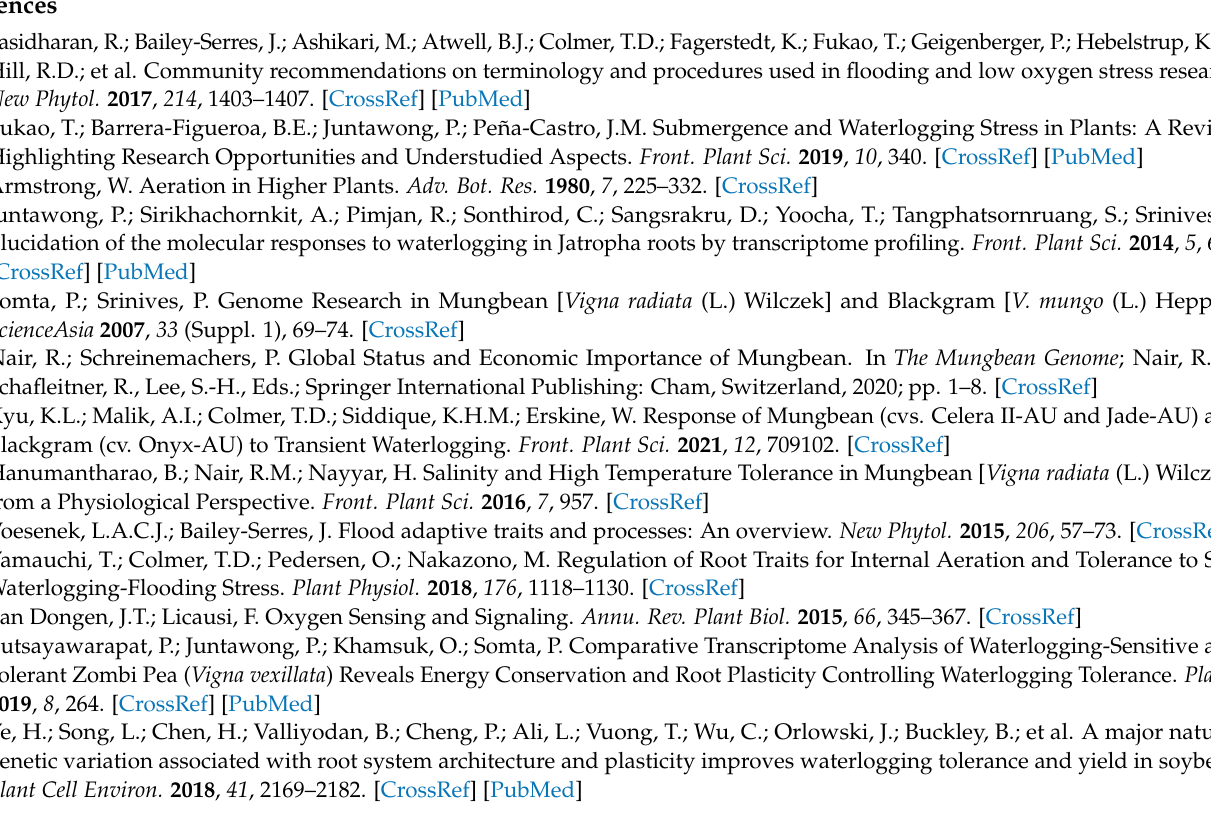
genes; Table S1. Read statistics; Table S2. Differentially expressed genes (DEGs) from seven compar- isons: D1H150/NSH150; D1KPS2/NSKPS2; D7H150/NSH150; D7KPS2/NSKPS2; NSH150/NSKPS2; Table S4. GO enrichment analysis derived from Venn’s diagram comparison.; Table S5. Overrepre- sentation analysis by PAGEMAN tool. Log 2 Fold Change cutoffs: 1 and 2.; Table S6. The pattern of Fuzzy k-mean clusters; Table S7. GO enrichment analysis derived from Fuzzy k-mean clusters; Table S8. Primers used for quantitative real-time